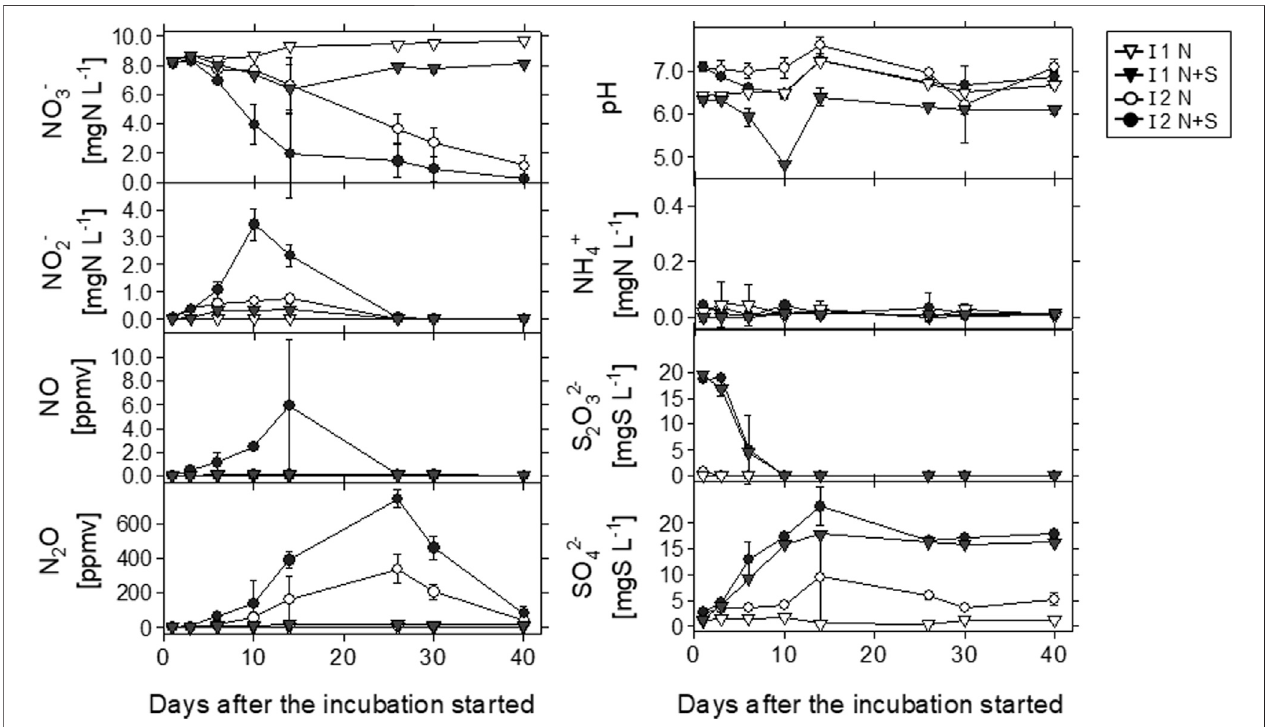
FIGURE 3 | Temporal variations of pH and the concentrations of aquatic and gaseous nitrogen species, S 2 O 32 − , and SO 42 − with different soils (I1 and I2) and treatments (N and N + S) in the long-term incubation experiment. N, KNO 3 solution; N + S, KNO 3 and Na 2 S 2 O 3 solution. Error bars indicate standard deviation ( n (cid:2) 3).